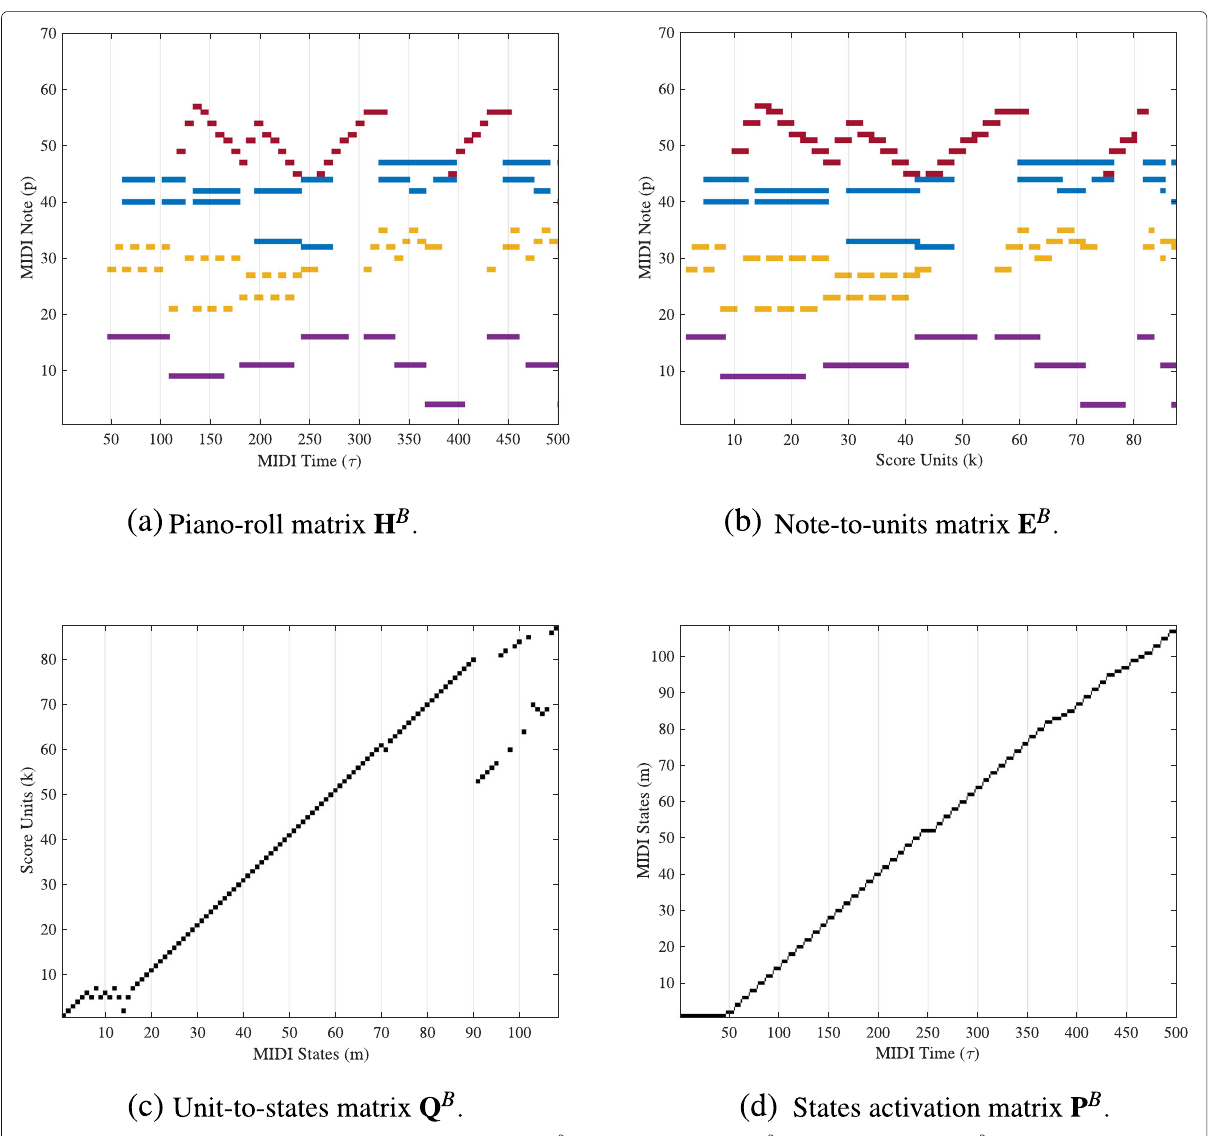
Fig. 2 Example of score matrix decomposition. a Piano-roll matrix H B . b Note-to-units matrix E B . c Unit-to-states matrix Q B . d States activation matrix P B . The instruments (dimension j ) in a and b are displayed using different